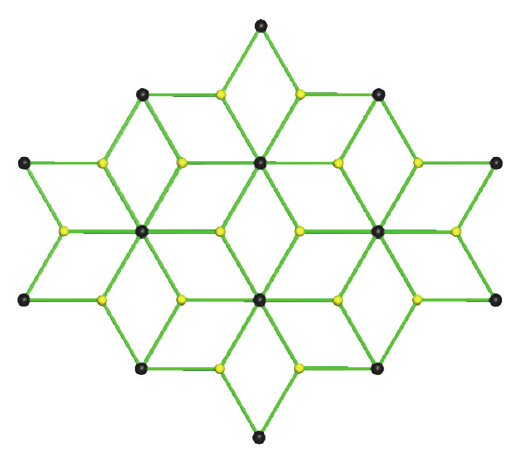
Figure 6: A view of the 2D hydrogen-bonded kgd -(4 3 ) 2 (4 6 .6 6 .8 3 ) net adopted by complexes 2 – 4 . Black spheres represent the 6- connected [M(DEU) 6 ] 2+ cations [M = Co ( 2 ), Ni ( 3 ) and Zn ( 4 )] and yellow spheres the 3-connected ClO 4 −